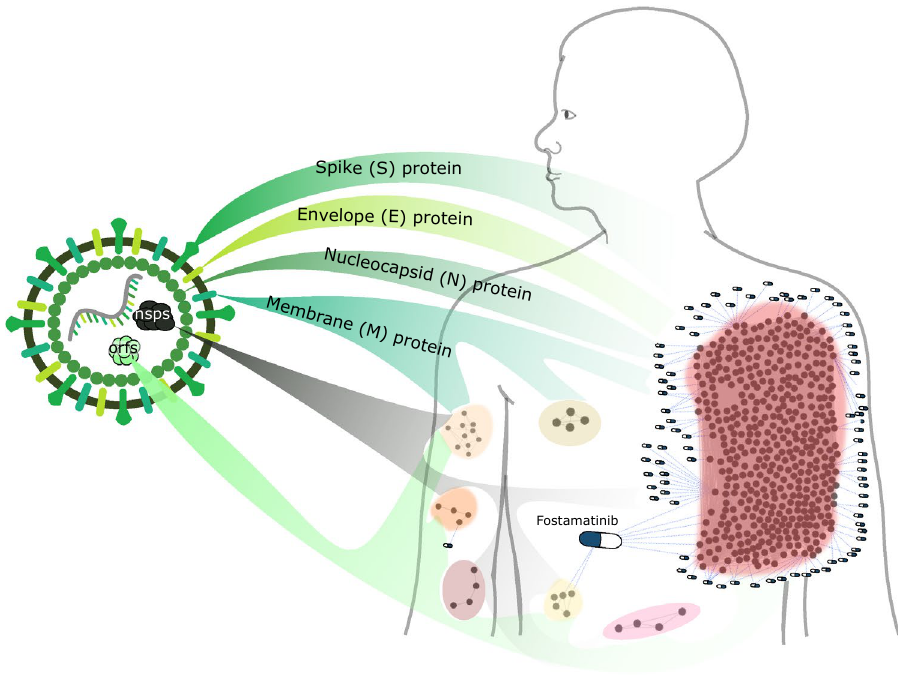
Figure 4. Drug targeting of the COVID-19 disease modules. Bipartite network linking drugs with their targets in the COVID-19 disease modules, where nsps are the SARS-CoV-2 non-structural proteins and orfs are its other open reading frames. Several polypharmacological drugs can be observed, highlighting Fostamatinib as the only one that is linked to two modules. The remaining polypharmacological drugs are linked to one module